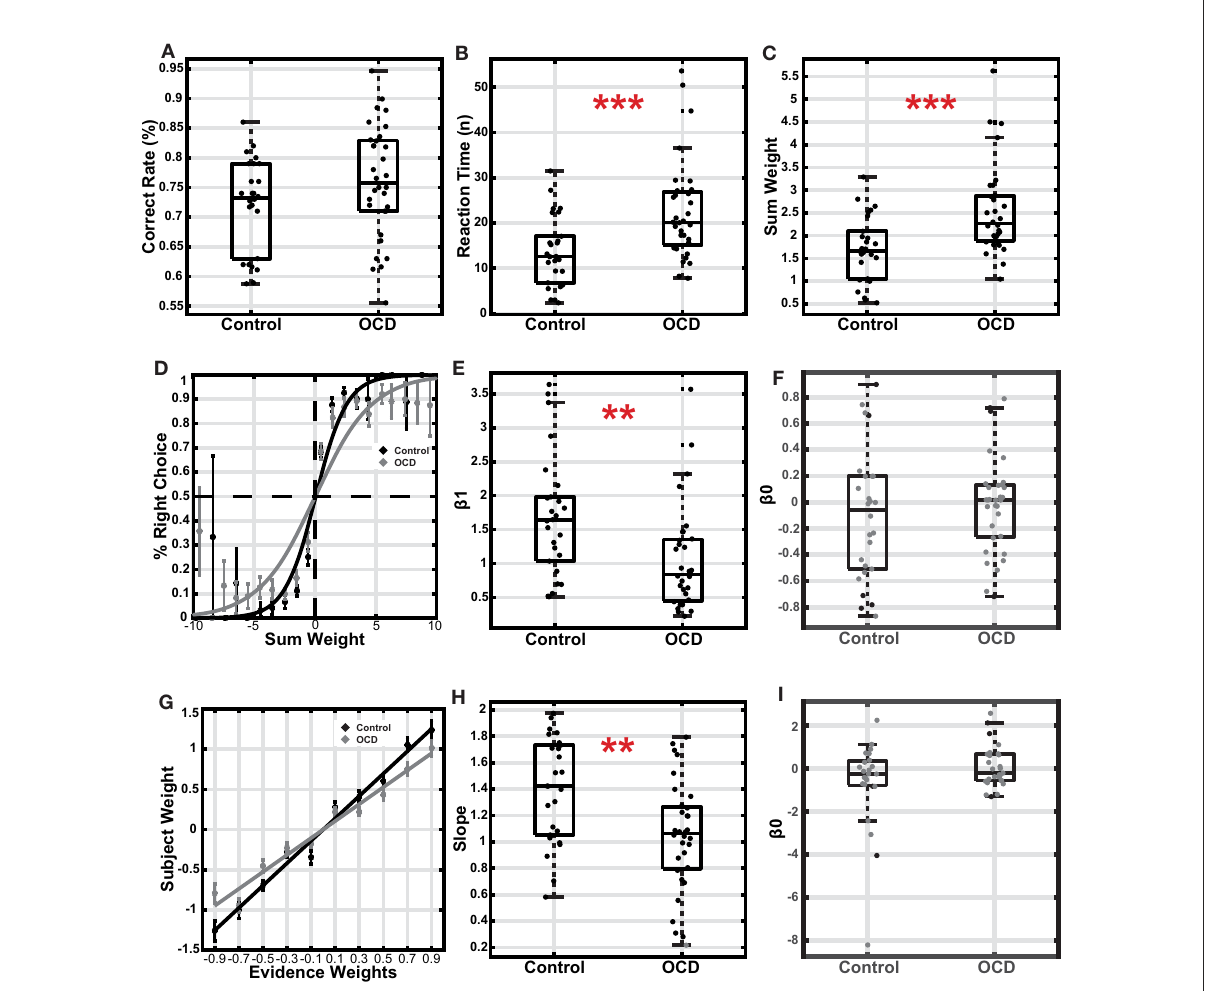
FIGURE2 Comparison between the OCD and the control group. (A) Accuracy. The boxes indicate the second and third quartiles, and the whiskers indicate a 99.3% interval. (B) Reaction time is measured with the number of stimuli used for decisions. (C) The sum weight of the stimuli used for decisions. (D) The choice was plotted as a function of sum weight. The data points and the error bars indicated the mean and the S.E.M. across subjects. The curves were based on the logistic regression fitting to all trials of each group’s subjects. (E) The logistic regression coefficient β 1 of individual subjects. (F) The logistic regression coefficient β 0 (intercept) of individual subjects. (G) The subjective weights plotted against the assigned weights for each type of arrow. The data points and the error bars indicated the mean and the S.E.M. across subjects. (H) The slopes of the fitted lines of the subjects’ subjective weights. (I) The logistic regression coefficient β 0 (intercept) of individual subjects. The gray dots indicated subjects with slopes not significantly different from zero, who were excluded from the analysis ** p < 0.01, *** p < 0.001.